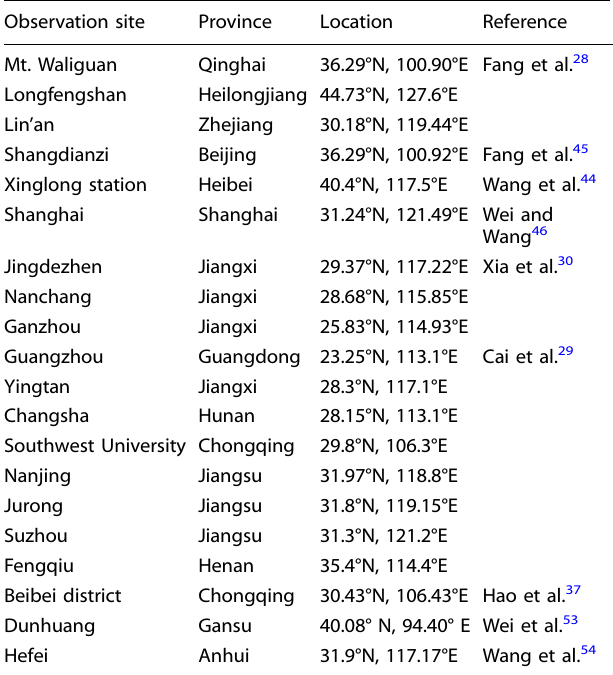
Table 2. The locations of sampling sites from previous CH 4 observation